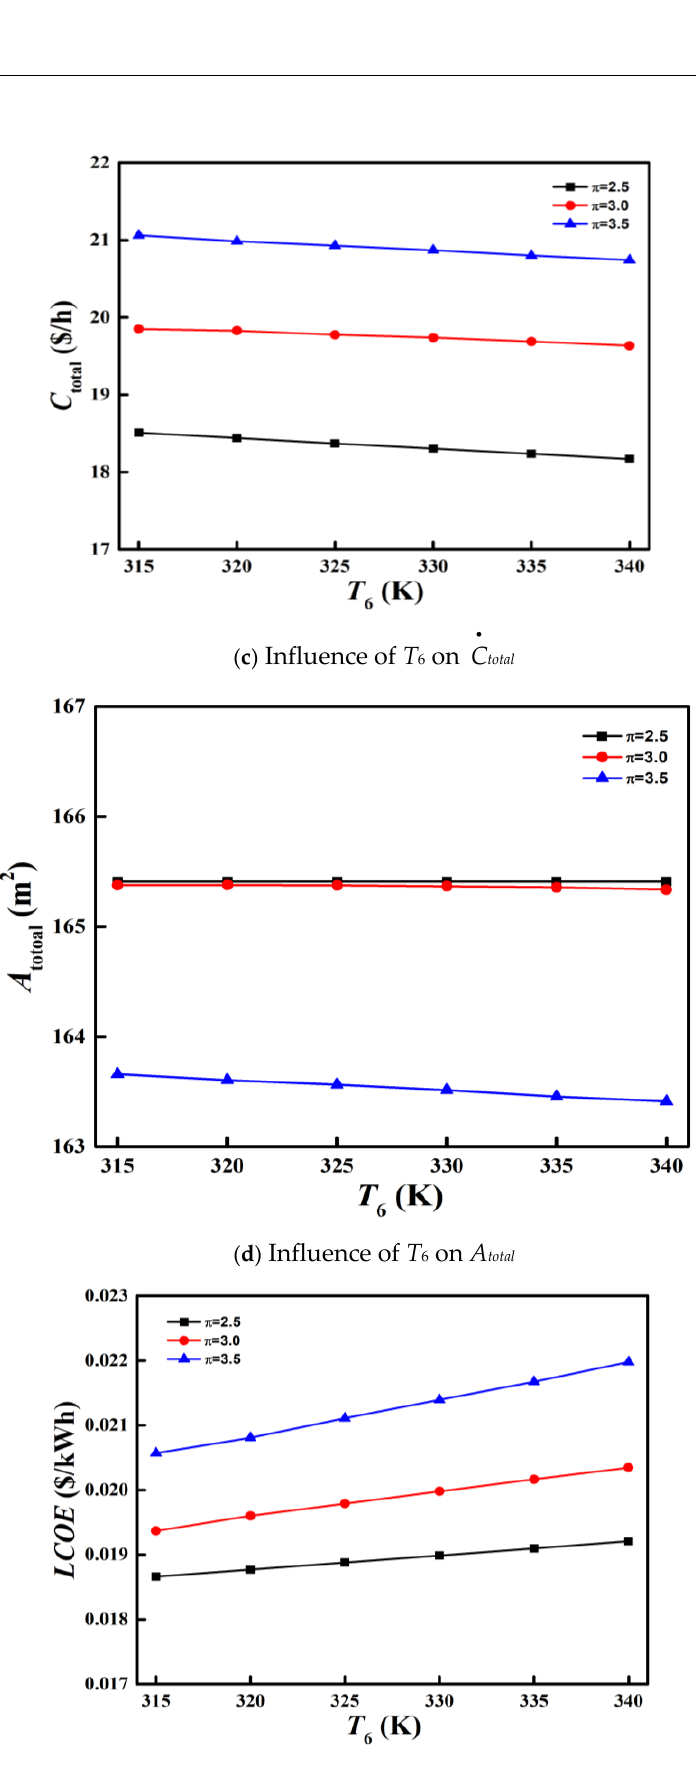
Figure 8. Influence of T 6 on the proposed S-(N 2 O-He) cycle.